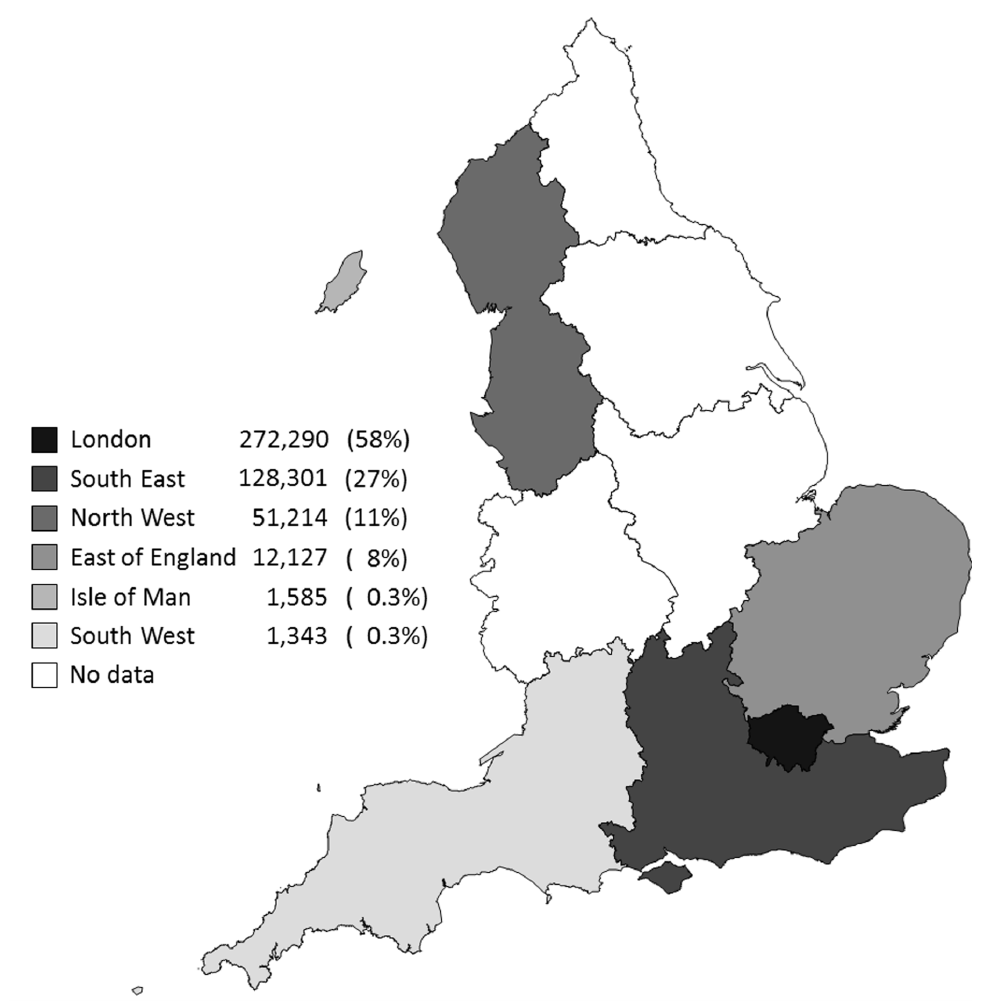
Figure 1. Number of women who provided folic acid supplement status according to strategic health authority and the Isle of Man.